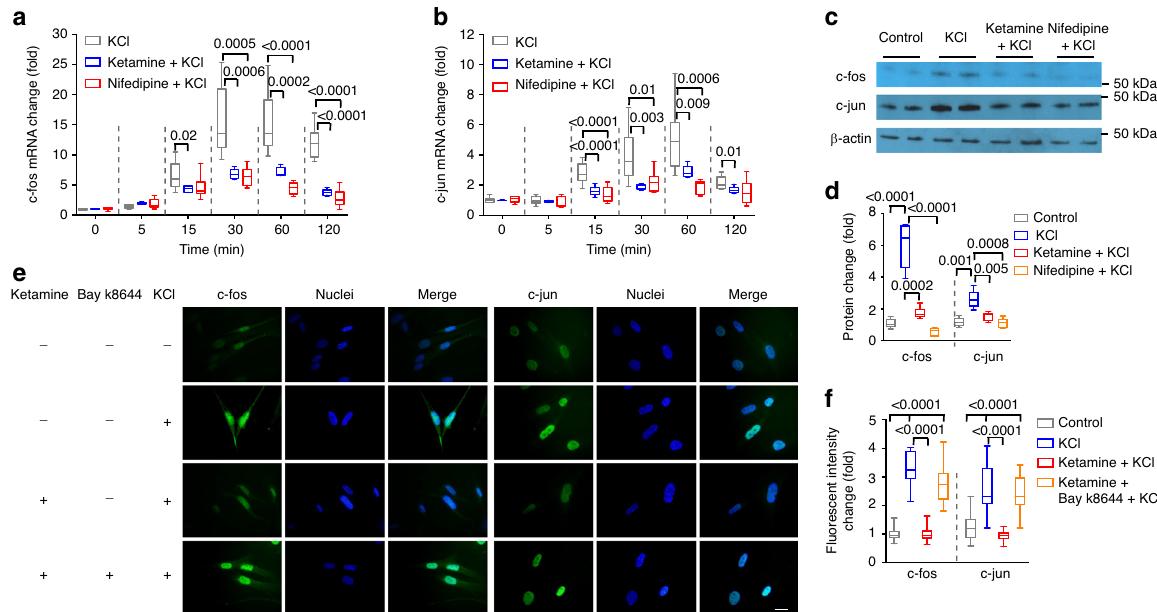
Fig. 6 Ketamine reduces Cav1.2-stimulated mRNA and protein levels in BSM cells. Mouse BSM strips were subjected to 50 mM KCl activation of Cav1.2 for 0 – 120 min and then lysed for mRNA preparation. Changes in c-fos ( a n = 9 BSM strips) and c-jun ( b n = 9 BSM strips) mRNA were measured by quantitative RT-PCR. Upregulation of both c-fos and c-jun were inhibited by 100 µ g ml − 1 ketamine and by 10 µ M nifedipine. c Representative immunoblot from two independent experiments showing that upregulation of c-fos and c-jun by 30 min treatment with 50 mM KCl to activate Cav1.2 was inhibited by ketamine (100 µ g ml − 1 ) and by nifedipine (10 µ g ml − 1 ). d summarized data ( n = 5 BSM strips) of experiments similar to that shown in c . e 50 mM KCl upregulated expression and nuclear translocation of c-fos and c-jun in human BSM cells in a manner inhibited by ketamine (100 µ g ml − 1 ) and rescued by Bay k8644 (200 nM). Scale bar: 20 µ m. These images, representative of two separate triplicate experiments, are summarized in f ( n = 38 – 46 BSM cells). Data are shown as box and whiskers, center line is the median of the data set, box represents 75% of the data, and bars indicates whiskers from minimum to maximum. Data are analysed by two tailed Student ’ s t -test. P < 0.05 is considered to be signi fi cant and P values are given above the bars. Source data are provided as a Source Data fi